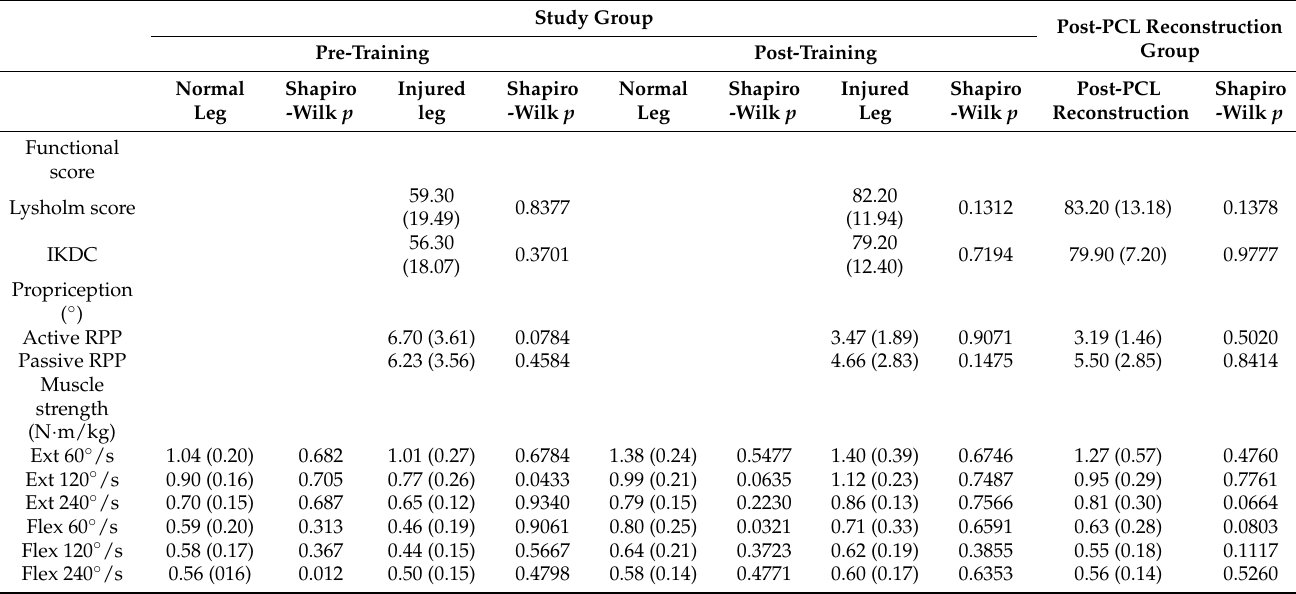
Table 2. Experimental data in the study (training) and post-PCL reconstruction groups.